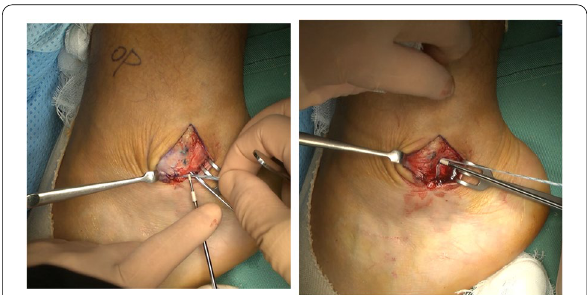
Fig. 5 Direction of the anchors inserted. First, the anchor is inserted from the tip of the lateral malleolus in the direction of the fibula head. (Left) Other three suture anchors are inserted at an angle of 30° from the lateral aspect of the fibula. (Right)